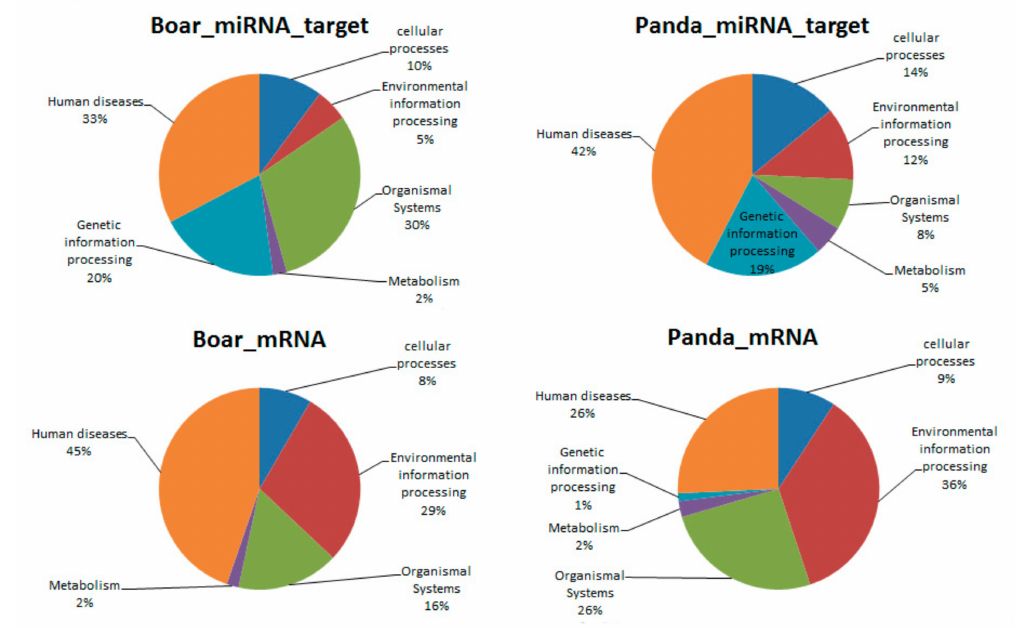
Figure 4. Kyoto Encyclopedia of Genes and Genomes (KEGG) pathway distribution of DE mRNAs and targets of DE miRNAs in boar and giant panda sperm.